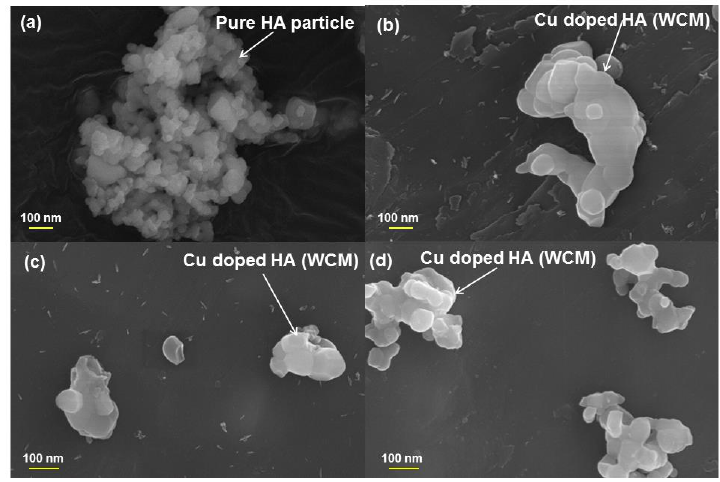
Figure A2. FESEM images of samples (a) HAWCM, (b) HA2WCM, (c) HA6WCM and (d) HA8WCM synthesised via the wet chemical route.